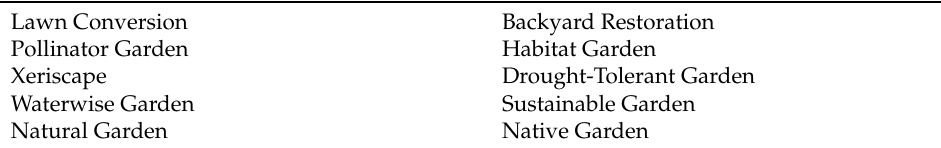
Table 1. Terms used to describe urban